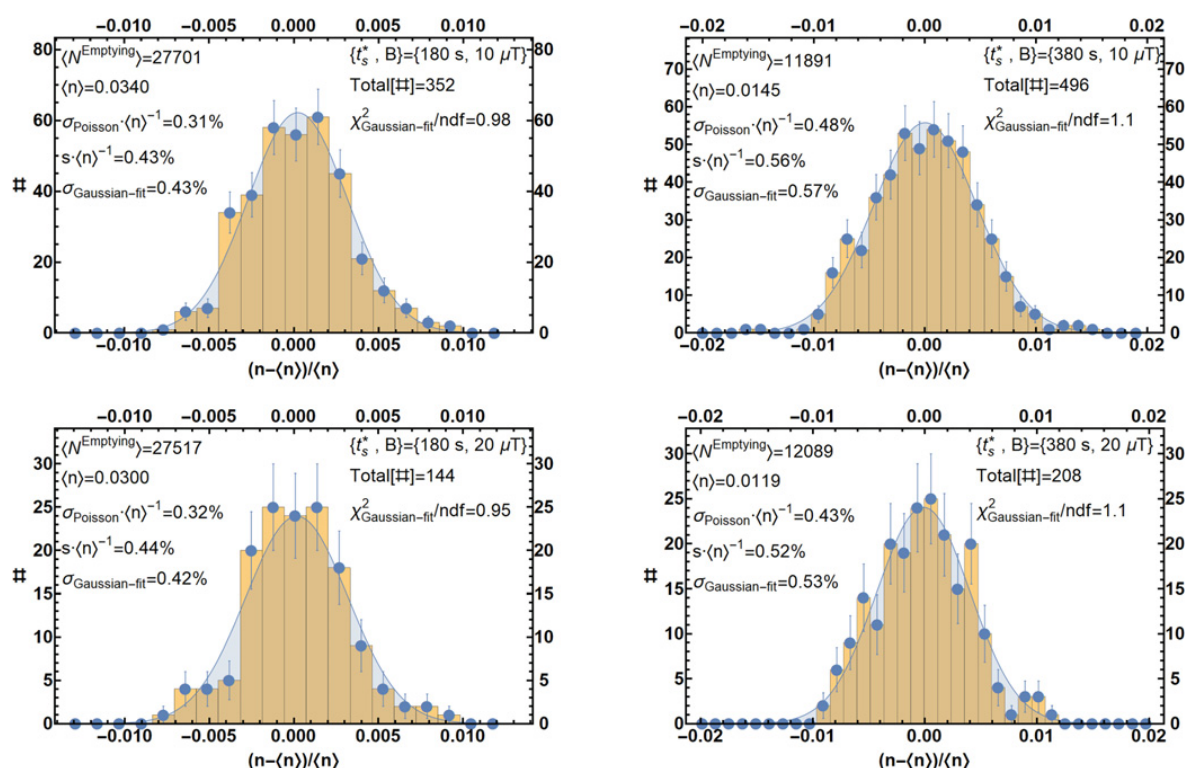
Figure 4. Histograms of normalized residuals of the ratio between emptying and monitor counts from Fig. 3 (bottom), along with the corresponding best fit with a Gaussian distribution. In clockwise order: top-left corresponds to dwells with run identifiers of = 180 s and B ∼ 10 µ T; top-right corresponds to dwells with run identifiers of t ∗ = 380 s and B ∼ 10 µ T; bottom-right t ∗ 0 0 s s = 380 s and B ∼ 20 µ T; bottom-left corresponds to dwells with run identifiers of corresponds to dwells with run identifiers of t ∗ 0 s = 180 s and B ∼ 20 µ T. The extracted values are explained in the text. t ∗ 0 s